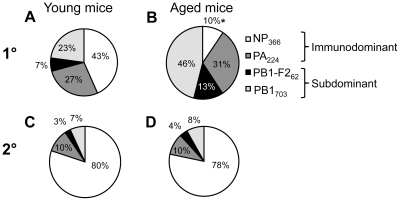
Immunodominance hierarchies in aged mice after 10 infection or 20 challenge of primed-early mice.The relative prevalence of the immunodominant DbNP366
+CD8+ and DbPA224
+CD8+ T cell population over the subdominant DbPB1703
+CD8+ and KbPB1-F262
+CD8+ sets. Results are shown for (A, B) 10 and (C, D) 20 HK infection in (A, C) young and (B, D) aged mice. The relative contributions of particular antigen-specific CD8+ T cells were analysed based on total cell responses (Figure 1 for DbNP366
+CD8+ and DbPA224
+CD8+ and data not shown for DbPB1703
+CD8+ and KbPB1-F262
+CD8+). Data represent the mean proportion of a particular peptide-specific CD8+ population. * = p<0.01 shows a difference between young and aged animals. Experimental outline as in Figure 1AB.